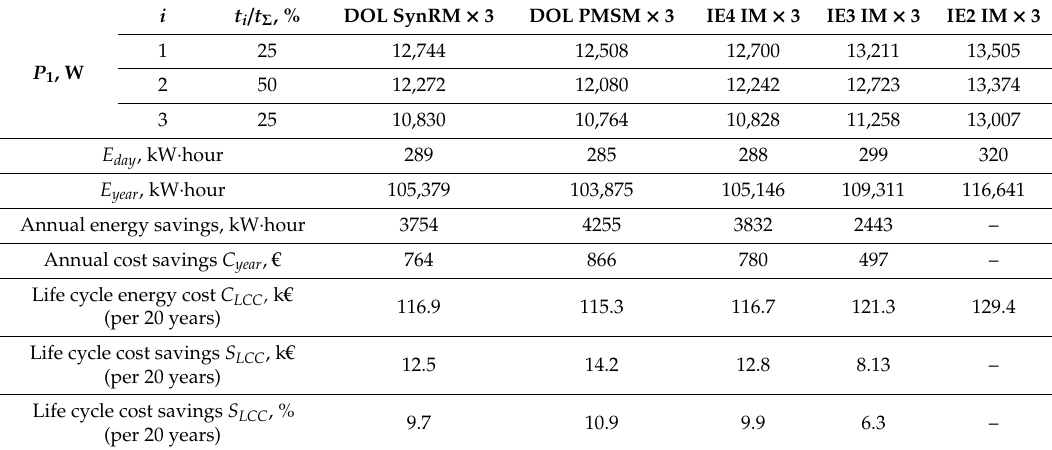
Table 8. Calculation of the energy consumption of three pump units considering the cable and transformer losses (case 3, m = 3).